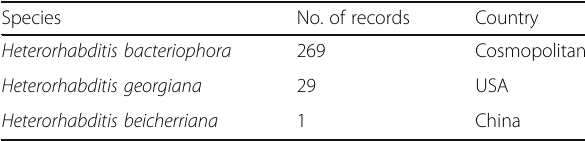
Table 4 Number of ITS sequences belonging to the group of Heterorhabditis bacteriophora , present in the GenBank database Species